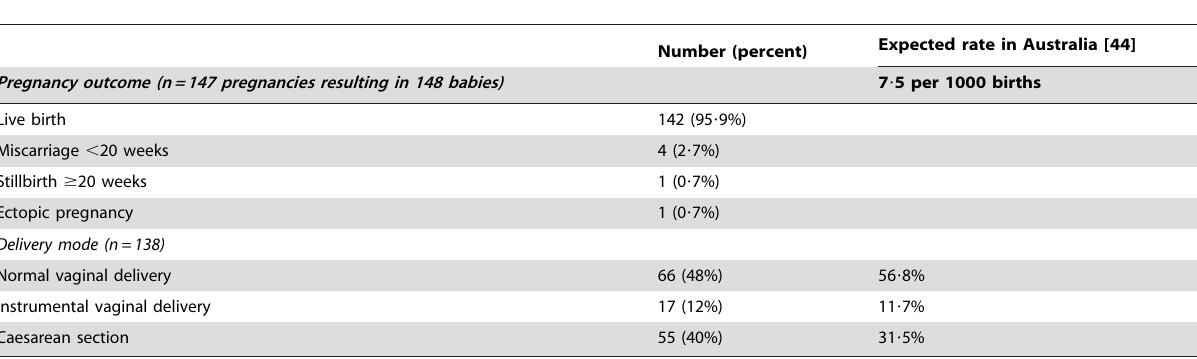
Table 3. Pregnancy outcomes and mode of delivery.